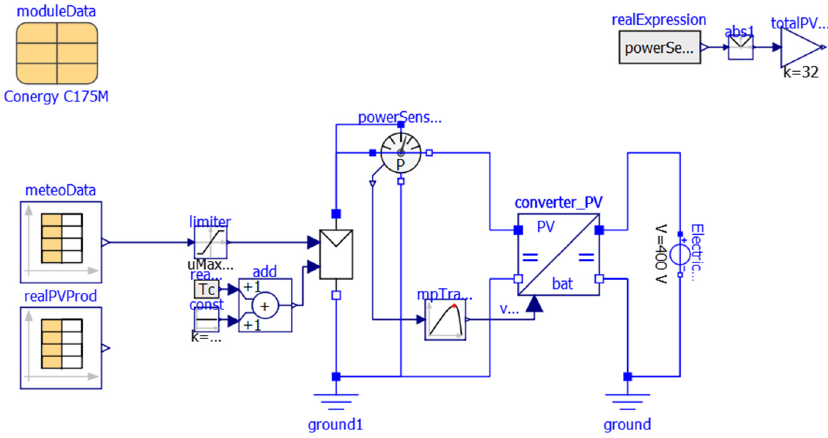
Figure 8. Block diagram representation of ESTIA1 building PV installation.